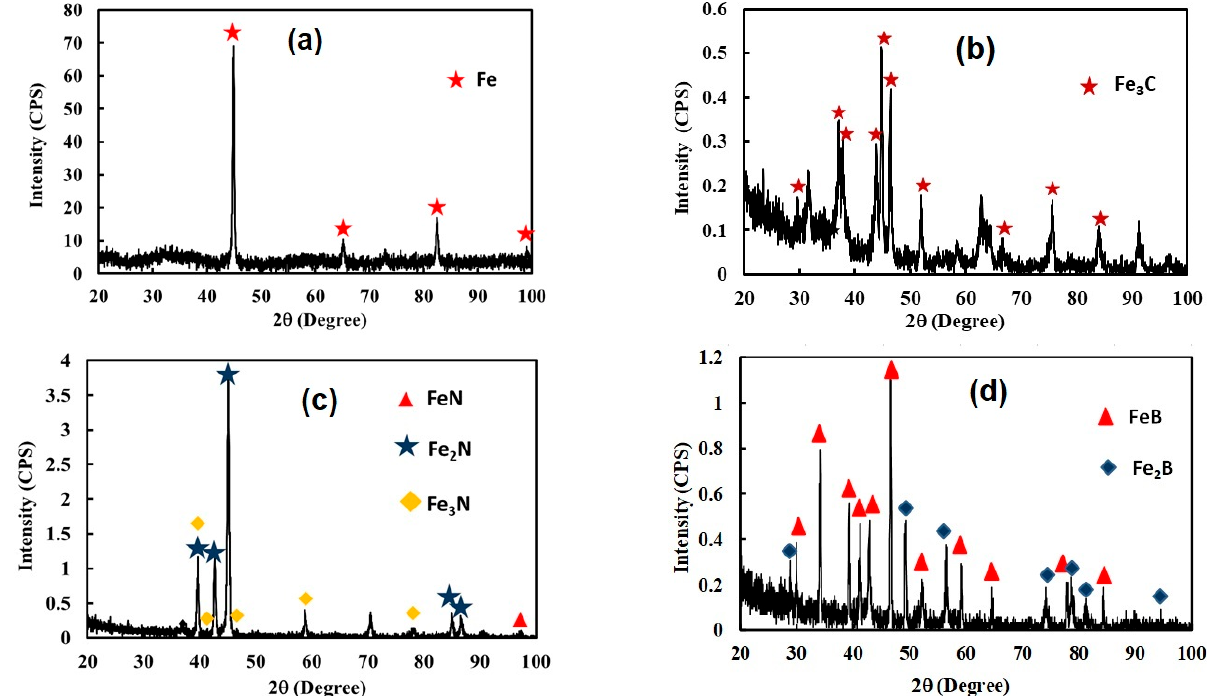
Figure 3. X-ray diffraction patterns of the AISI 4140 ( a ) untreated, exposed to ( b ) carburizing, ( c ) nitriding, and ( d ) boriding. ( c ) nitriding, and ( d )